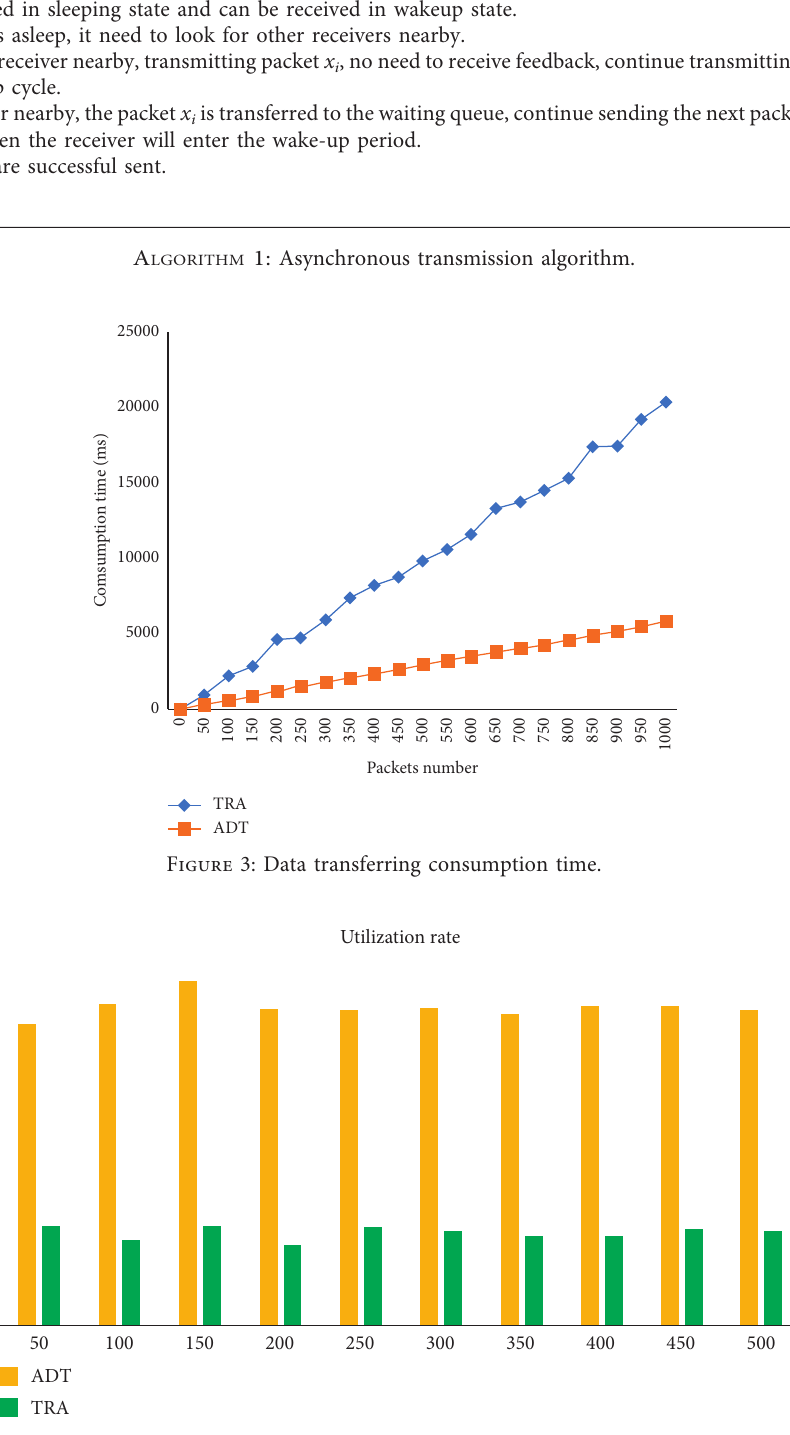
Figure 4: Data transferring channel